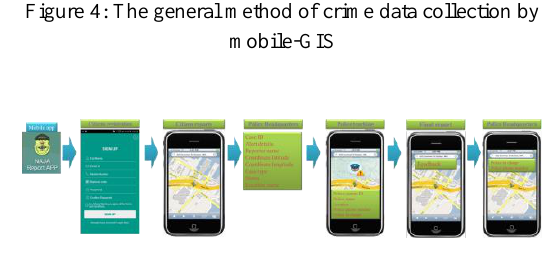
Figure 5: The detail of utilize Mobile-GIS app